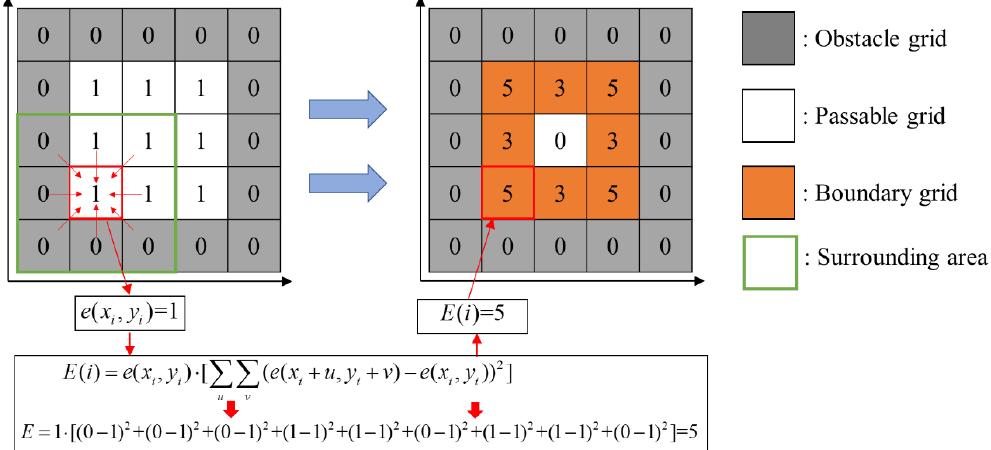
Figure 5. The calculation process example of the boundary judgment parameter for each grid.